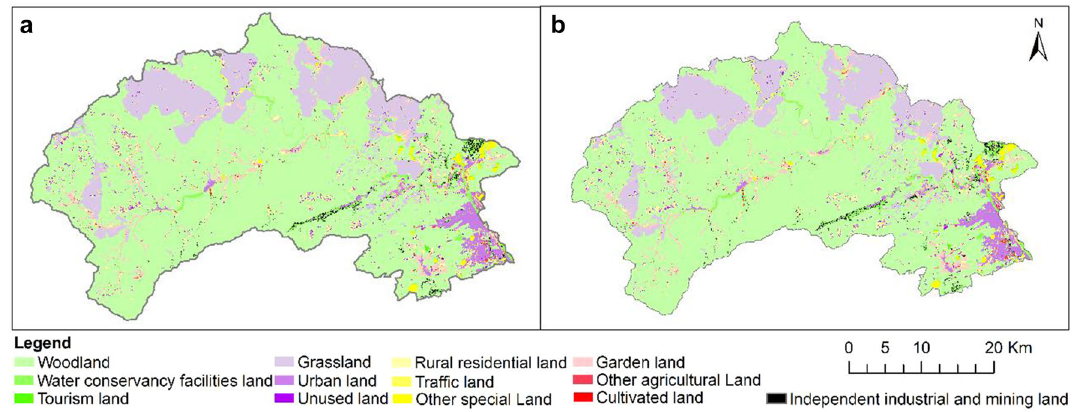
Fig. 5 Land use status ( a ) and simulation results ( b ) of Mentougou District in